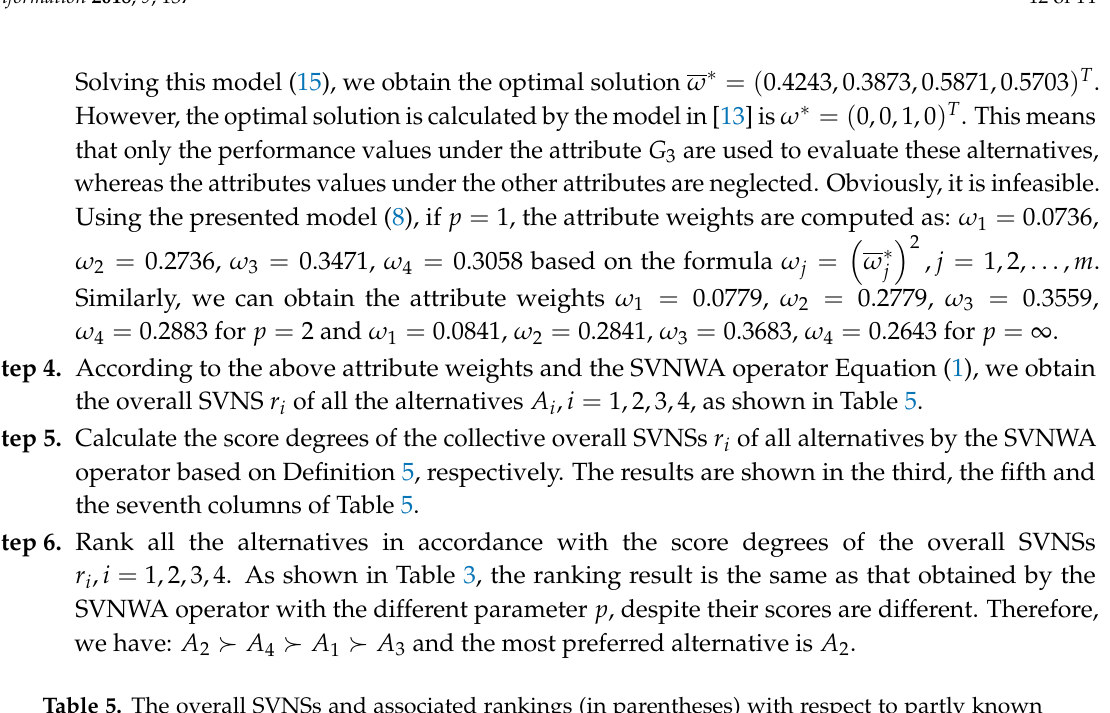
Table 5. The overall SVNSs and associated rankings (in parentheses) with respect to partly known attribute